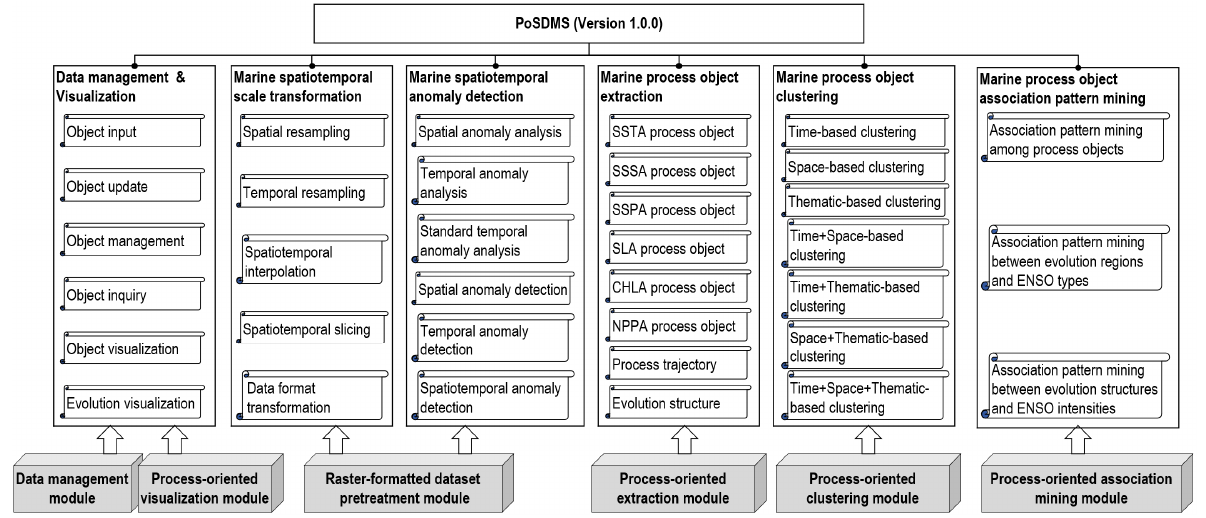
Figure 9. Logics between functions and modules of PoSDMS.